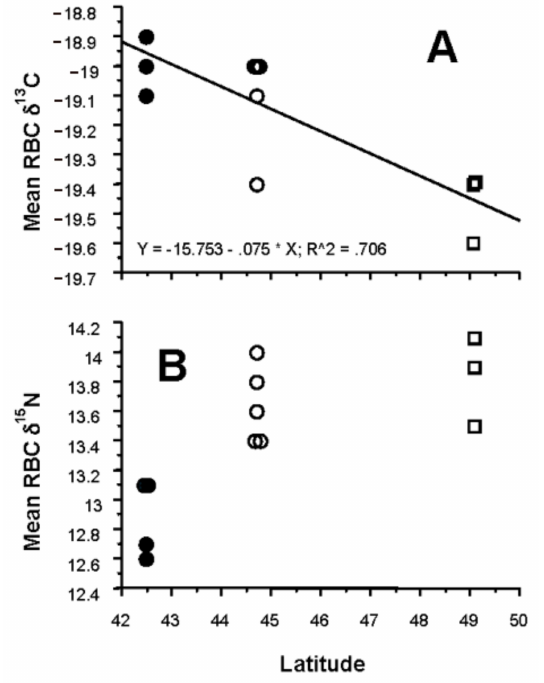
Figure 4. Linear regression (Panel A) shows a strong and significant negative relationship between latitude where the great shearwaters were captured and the δ 13 C of their RBCs ( p = 0.0006), while ANOVA (Panel B) found the δ 15 N of the shearwater RBCs in the Massachusetts Bay / Cape Cod (mean d15N = 12.9) area to be less ( p < 0.05) than that of those captured in the Bay of Fundy (mean δ 15 N = 13.8) or o ff the northeast coast of Newfoundland (mean δ 15 N = 13.6). A Fishers PLSD showed that the latter two did not di ff er significantly from each other ( p > 0.05). The symbols represent the mean δ -values of RBCs for each capture event (see Table 1). Black circles represent this study, open circles represent capture events from Ronconi et al. [35], and open squares represent capture events from Gulka et al. [34]. Where multiple symbols overlap, the values were actually identical. It should be noted that while this study and Ronconi et al. [35] only captured great shearwaters, the Gulka et al. [34] study combined data from great and sooty